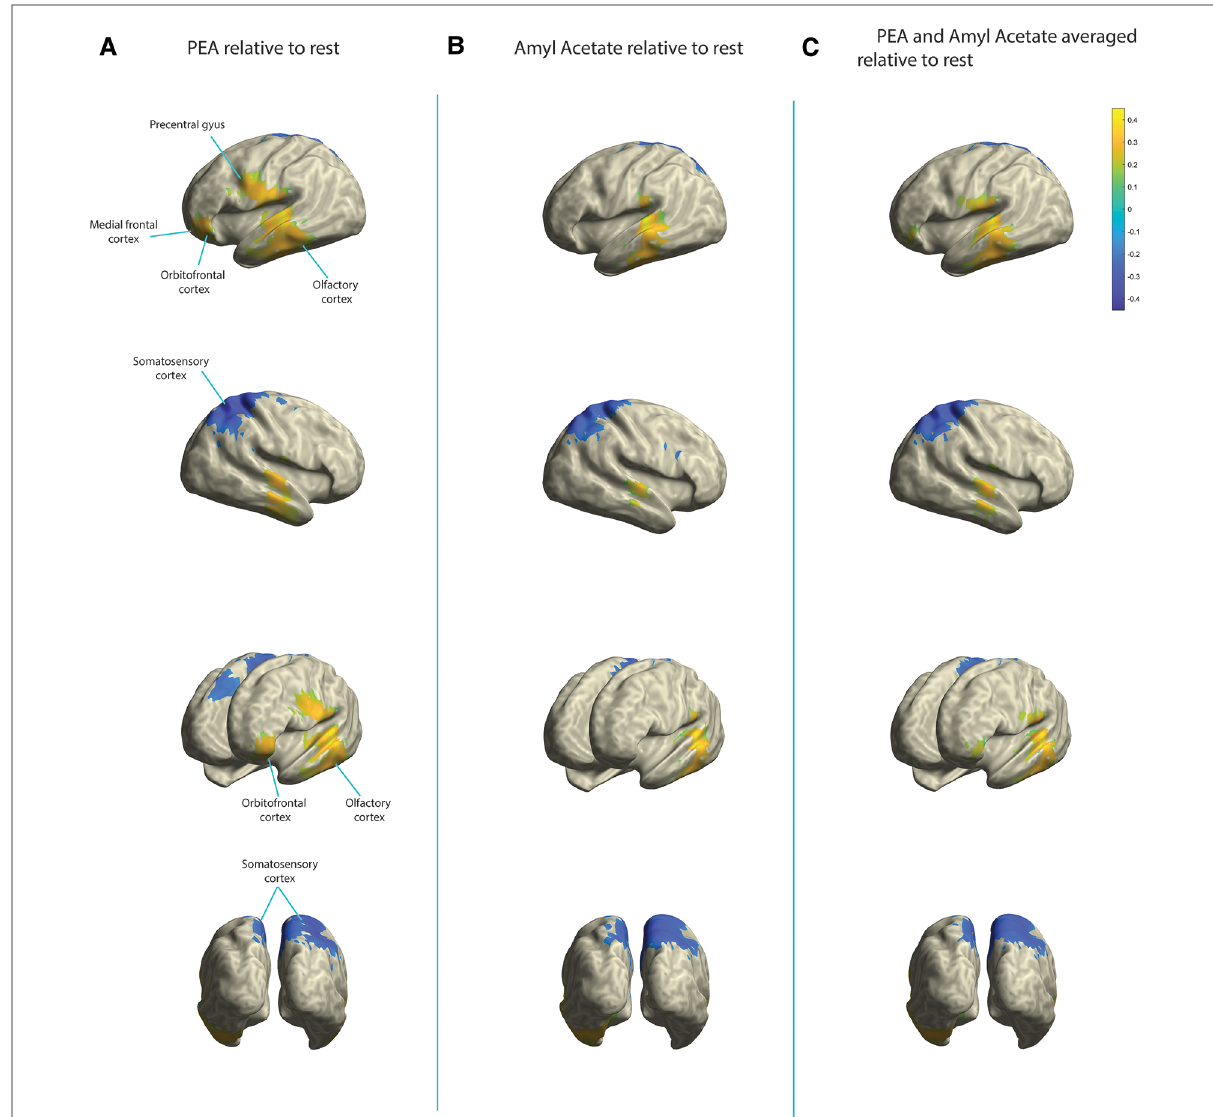
FIGURE 2 Change in relative alpha power in the olfactory cortex, somatosensory cortex, orbitofrontal cortex, medial frontal cortex, and precentral gyrus. Yellow indicates increases in activity and blue indicates decreases in activity. ( A ) PEA stimulation relative to rest. ( B ) Amyl acetate relative to rest. ( C ) Olfactory stimulation (PEA and amyl acetate signals averaged) relative to